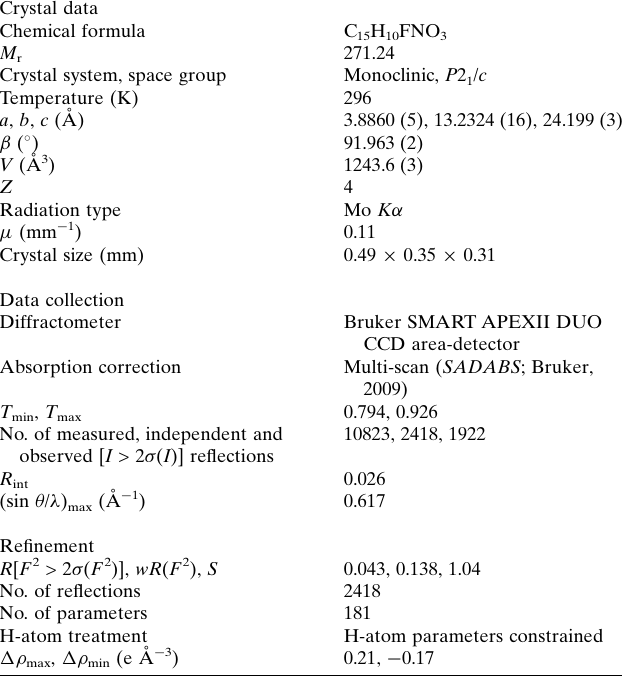
Table 2 Experimental details.